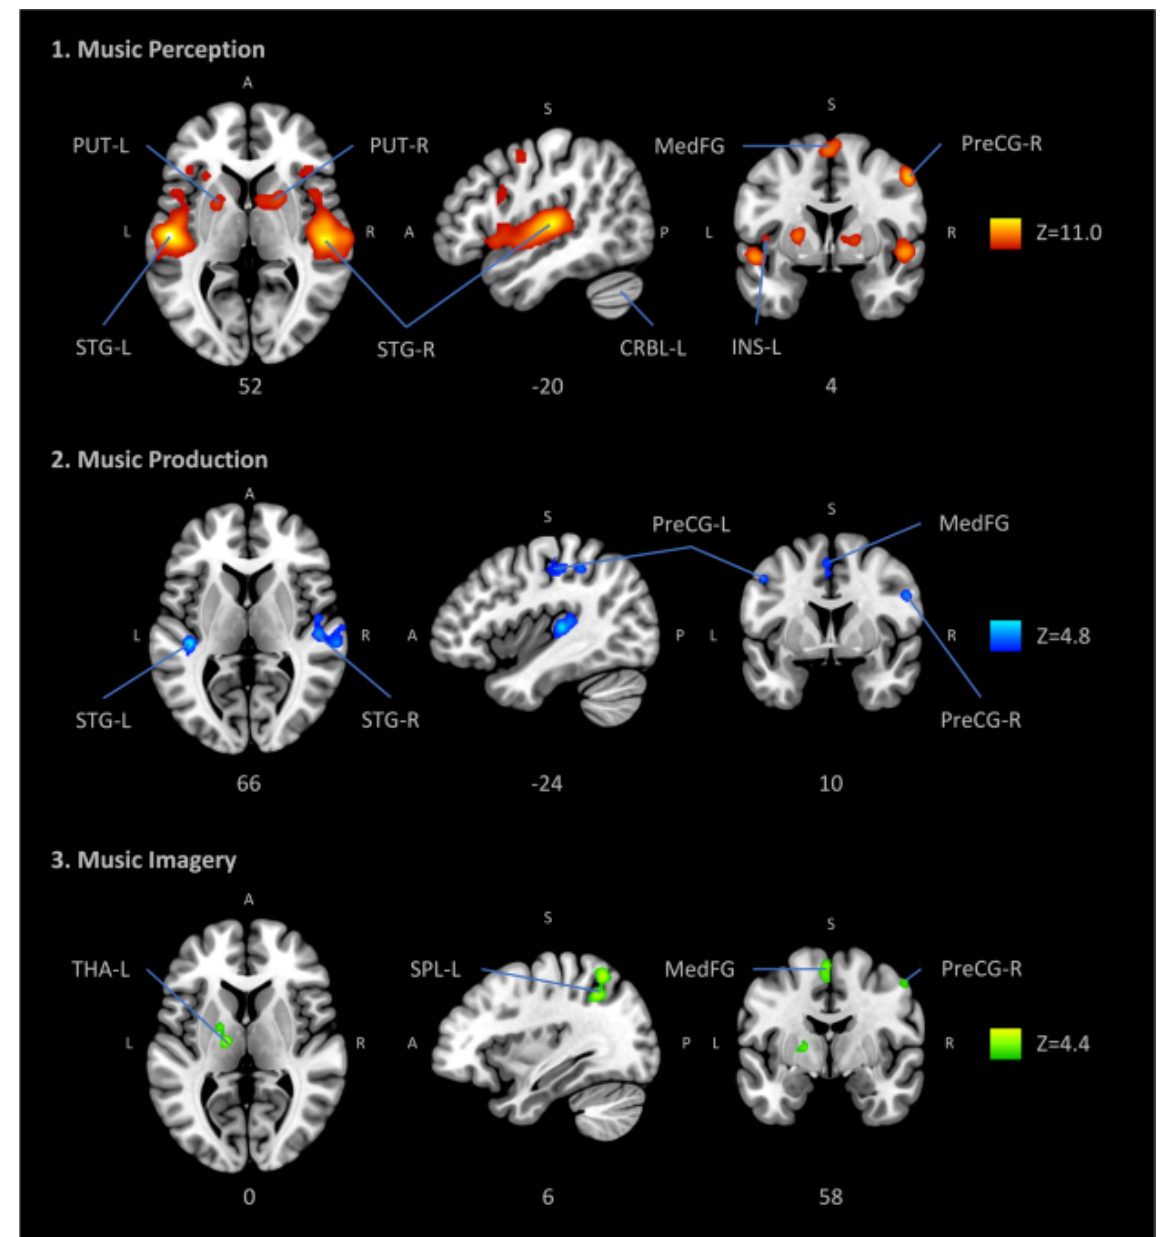
Figure 3. Automatic meta ‐ analysis obtained with neurosynth.org of 163 studies utilizing the fMRI methodology and including “music” as keyword. Brain structures related to audition (supratemporal cortex), motor control (dorsomedial prefrontal cortex and cerebellum), body awareness (insula) and reward (ventral striatum) are visible. ROIs: PUT putamen, STG superior temporal gyrus (primary auditory cortex), MedFG medial frontal gyrus, CRBL cerebellum, INS insula, PreCG precentral gyrus (primary motor cortex or M1), THA thalamus, SPL superior parietal lobule, Z peak Z ‐ value. (Figure reproduced without modification from [116] (© Springer, Creative Commons Attribution)).